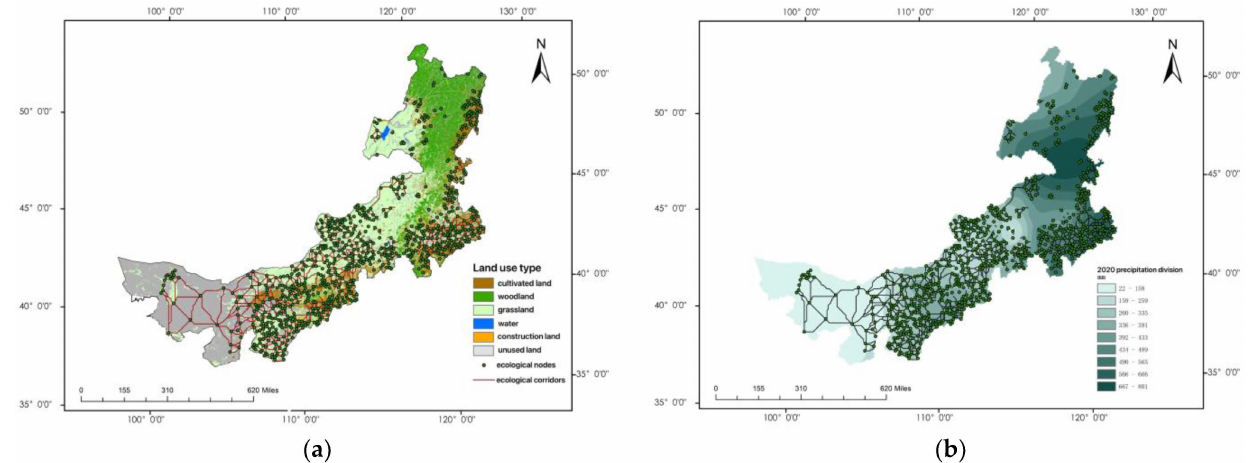
Figure 6. ( a ) Ecospatial network and land cover types in the study area; ( b ) ecospatial network and precipitation